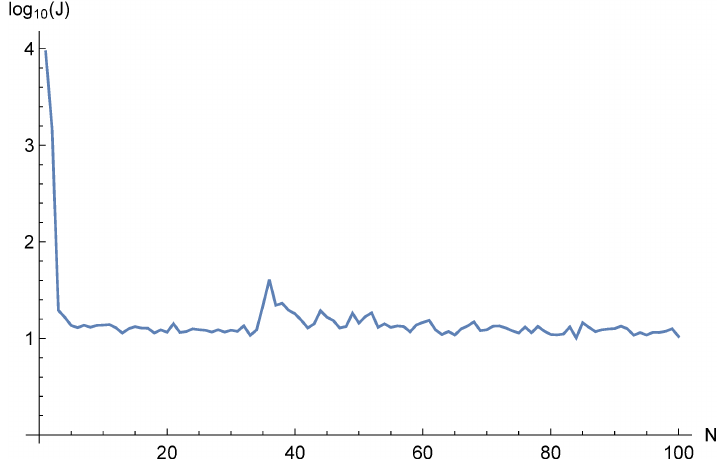
Figure 9. Plot of training loss J history of neural network solution nn 10 ( x ) (9) to problem (30), parameter value s = 0.01, with respect to number N of training epochs. Number of hidden layer neurons n = 20; sigmoid activation functions.